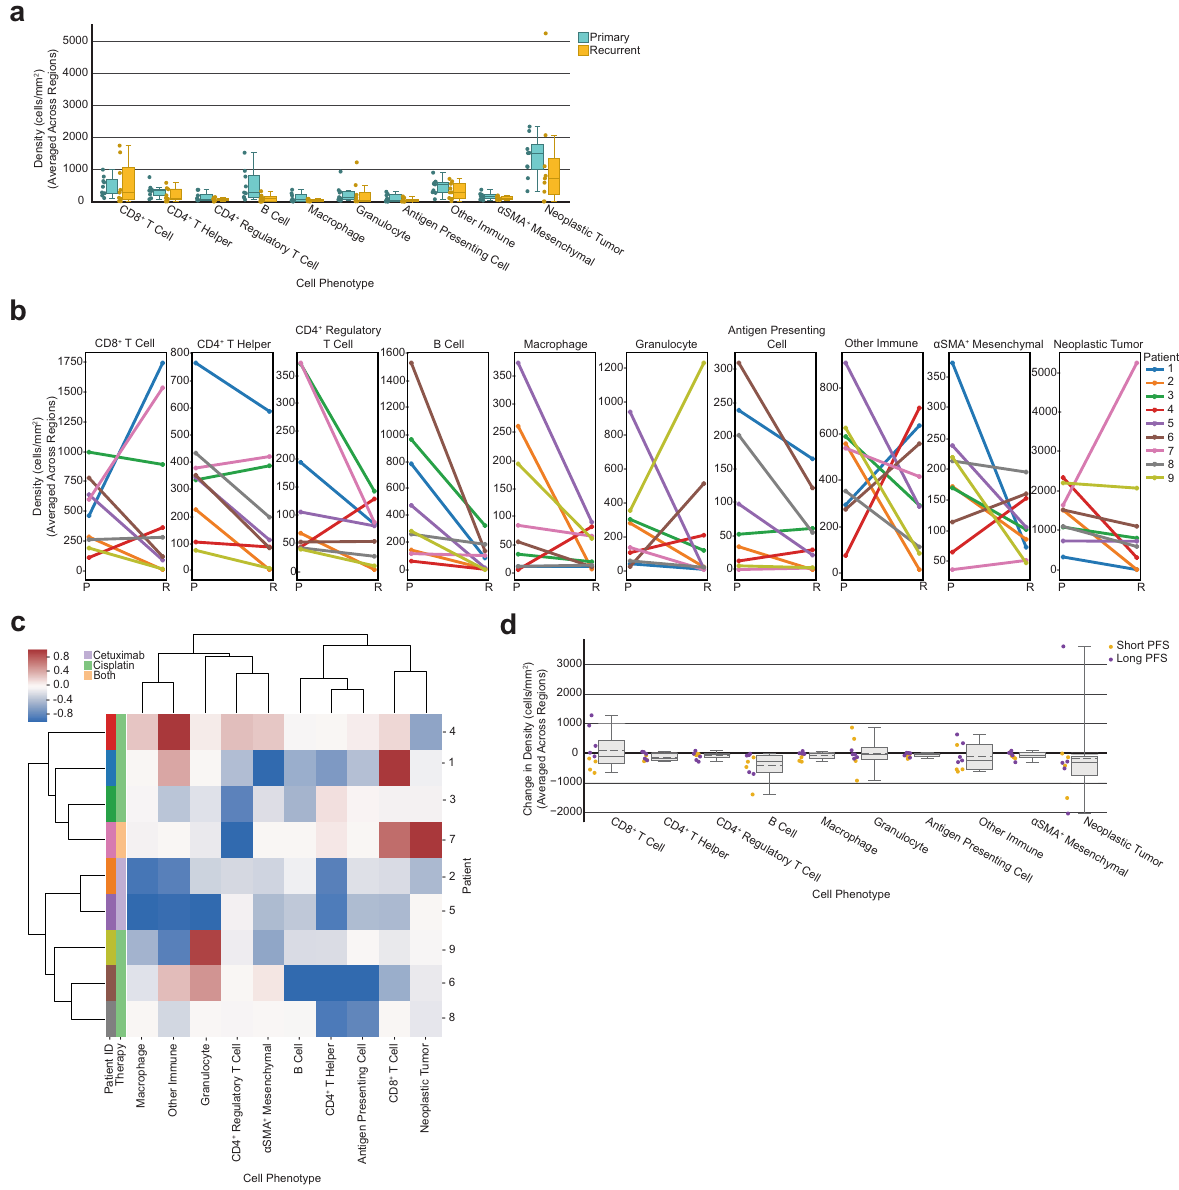
Fig. 2 Tumor cellular composition changes following therapy. a Box plot showing the average density of each cell type split by primary and recurrent status. Each dot represents the density of that cell type for one tumor, averaged across regions ( n = 9 primary tumors, n = 9 recurrent tumors). Boxes = quartile 1 (Q1) to quartile 3 (Q3); whiskers = smallest and largest datapoints within 1.5*interquartile range (IQR) + / − Q3/Q1; solid line = median. b Line plots showing the change in cellular composition from primary to recurrent tumors for each cell type. Each dot represents the density of that cell type for one tumor, averaged across regions. Lines are colored by patient. c Heatmap of average change in cellular composition from primary to recurrent tumors for each patient. Rows are individual patients that are ordered by the hierarchical clustering of their change in TiME cellular composition (averaged across regions). Columns are the cell types used as clustering features. Compositional change was normalized [ − 1,1] before clustering (see “ Methods ” section). Leftmost two columns are color coded by patient followed by therapy administered. d Box plot showing the average change in density of each cell type for each patient ( n = 9) colored by short-term or long-term progression free survival, splitting on median progression-free survival. Boxes = Q1 to Q3; whiskers = smallest and largest datapoints within 1.5*IQR + / − Q3/Q1; solid line = median; dotted line = difference in cellular composition for each cell type. This resulted in two groups of patients (Fig. 2c). Interestingly, the two patients